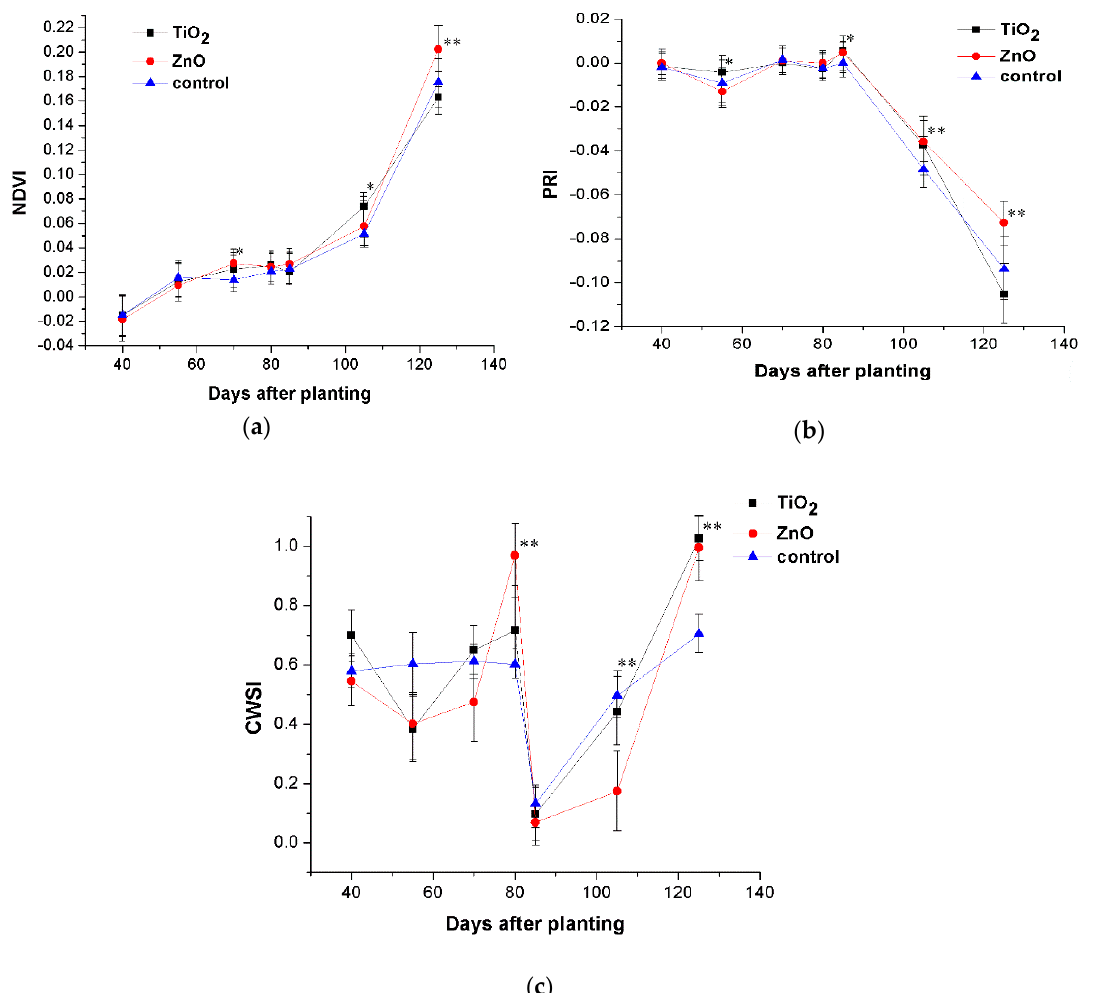
Figure 7. Analysed 2018 seasonal e ff ects of sunflower foliar-sprayed titanium dioxide and zinc oxide nanoparticles variants associated with the following physiological indices and compared to the control; ( a ) normalised di ff erence vegetation index (NDVI), ( b ) photochemical reflectance index (PRI) and ( c ) crop water stress index (CWSI), the significance: * P value < 0.05, ** P value <